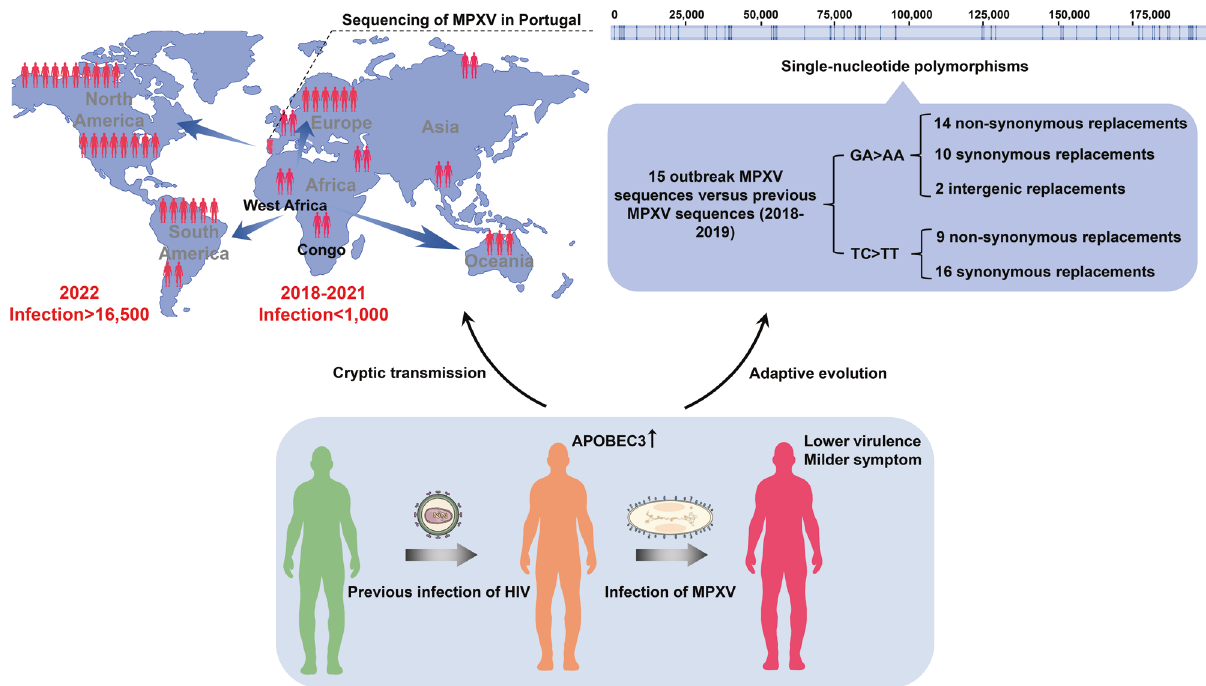
Fig. 1 APOBEC3-associated virus adaptive evolution may account for the monkeypox outbreak in 2022. The historical epidemiology and the genetic linkages suggested that the global monkeypox outbreak in 2022 might originate from epidemic regions (Africa). Sequencing analysis identi fi ed nearly 50 biased mutations (from GA to AA or TC to TT) in the genomes of recent monkeypox epidemics, indicating an accelerated evolution driven by APOBEC3. Coincidently, 218 (41%) of 528 monkeypox cases in the study of J.P. Thornhill et al. are also HIV patients with a high level of APOBEC3 expressions, which is bene fi cial for MPXV-biased mutations. The APOBEC3-derived mutations may further reduce the pathogenicity and symptoms caused by MPXV infection, leading to the cryptic transmission of monkeypox in populations and the global monkeypox outbreak, exhibiting the adaptive evolution of